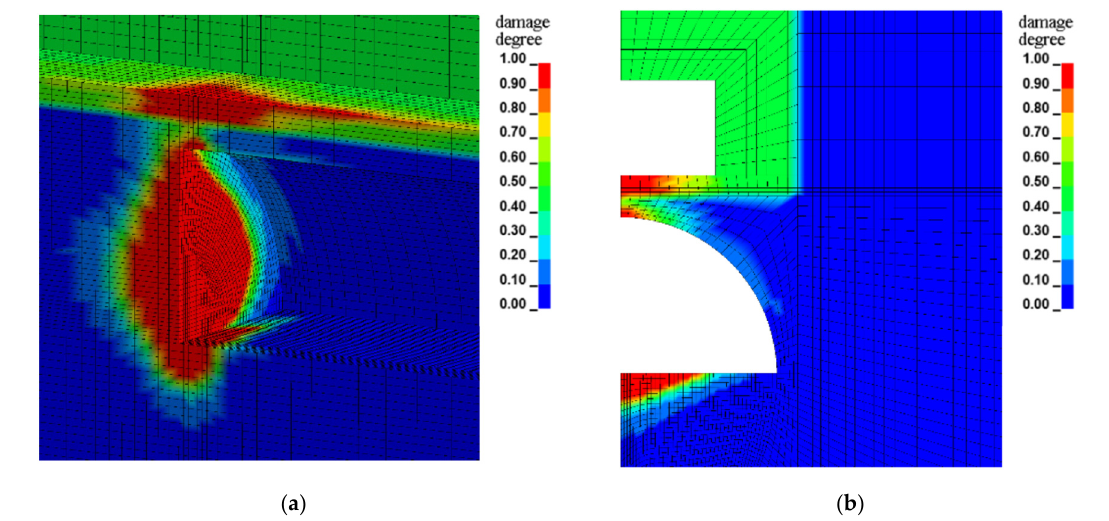
Figure 10. Blasting damage diagram of surrounding rock ( d = 1 m). ( a ) three-dimensional blasting damage diagram. ( b ) cross-section blasting damage diagram.